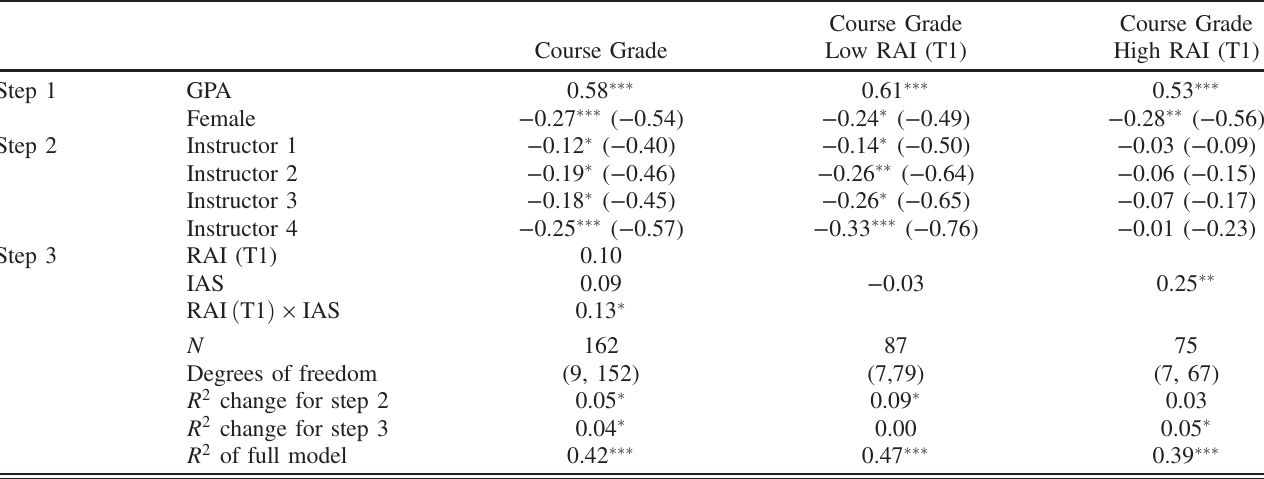
TABLE VI. Regression testing for the dependence of Course Grade on Instructor Autonomy Support, relative autonomous reasons for studying physics at the beginning of the course [RAI (T1)], and the interaction of IAS and RAI (T1), after controlling for GPA, gender, and differences in student performance among instructors (first column of numerical data). Regressions clarifying the interaction of IAS and RAI (T1) are also shown, one for students with below average RAI (T1) (penultimate column) and one for students with above average RAI (T1) (last column). Standardized correlation coefficients ( β ’ s) are given with accompanying p values, where (cid:2) p < 0 . 05 , (cid:2)(cid:2) p < 0 . 01 , (cid:2)(cid:2)(cid:2) p < 0 . 001 . For the dummy variables (Female and the instructor variables), the coefficients when only the dependent ’ s) are given in parentheses. The degrees of freedom, R 2 changes, and R 2 of the full model are also variables were standardized ( β DV given for each model. We see that the correlation of performance with IAS depended significantly on students ’ initial relative autonomous reasons for studying physics. IAS was positively correlated with performance, only for students initially studying physics for relatively autonomous